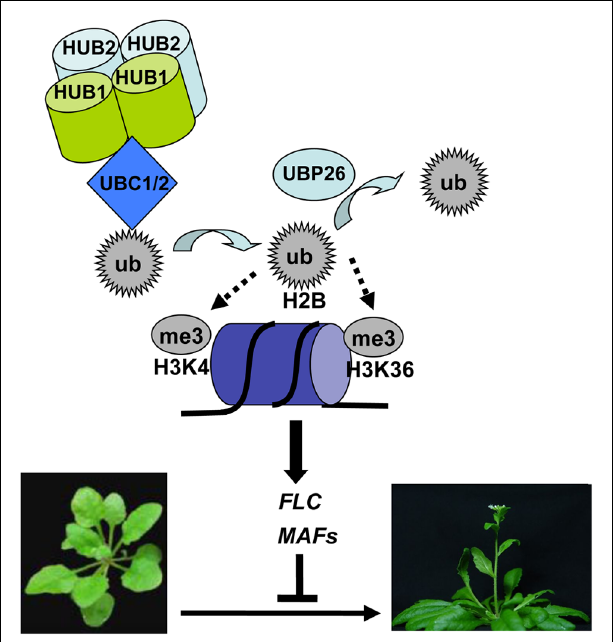
FIGURE 1 |A proposed model for deposition and removal of histone H2B monoubiquitination in transcriptional activation of FLC and MAFs in flowering time regulation. In this model, HUB1 and HUB2 form a heterotetramer and recruit UBC1 or UBC2 to FLC / MAFs chromatin, leading to transfer of a ubiquitin (ub) monomer from UBC1 or UBC2 onto H2B. H2Bub1 formation enhances H3K4me3 deposition by methyltransferases, together promoting transcription initiation. UBP26 removes ubiquitin on H2B, favoring H3K36me3 deposition in promoting transcription elongation. Active transcription of FLC/MAFs represses Arabidopsis flowering, a transition from vegetative to reproductive plant